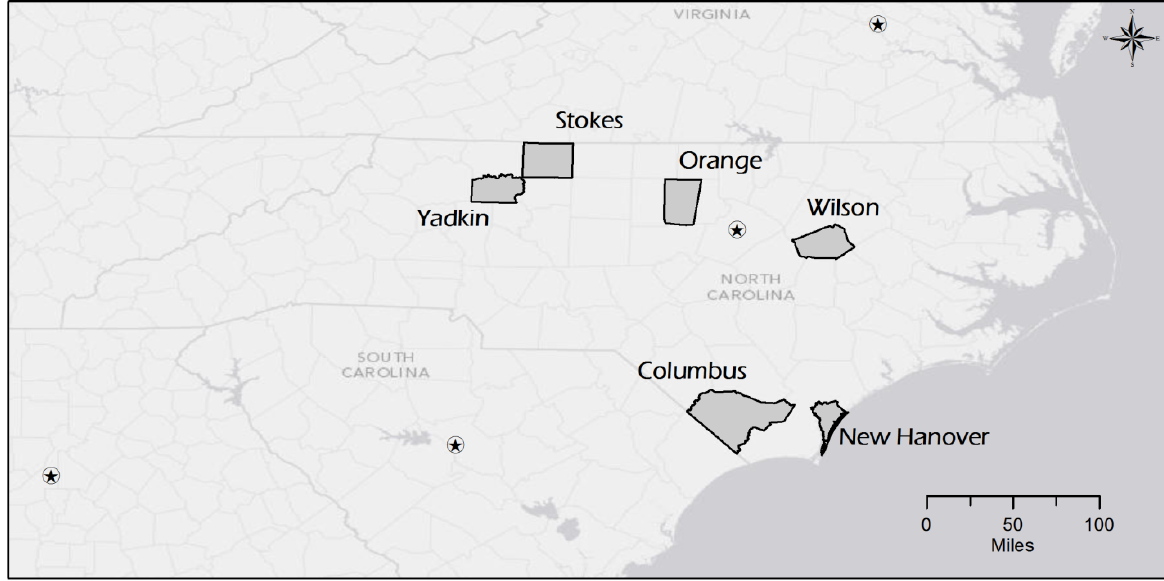
Figure 1. Map of Columbus, New Hanover, Orange, Stokes, Wilson, and Yadkin Counties, North Carolina,